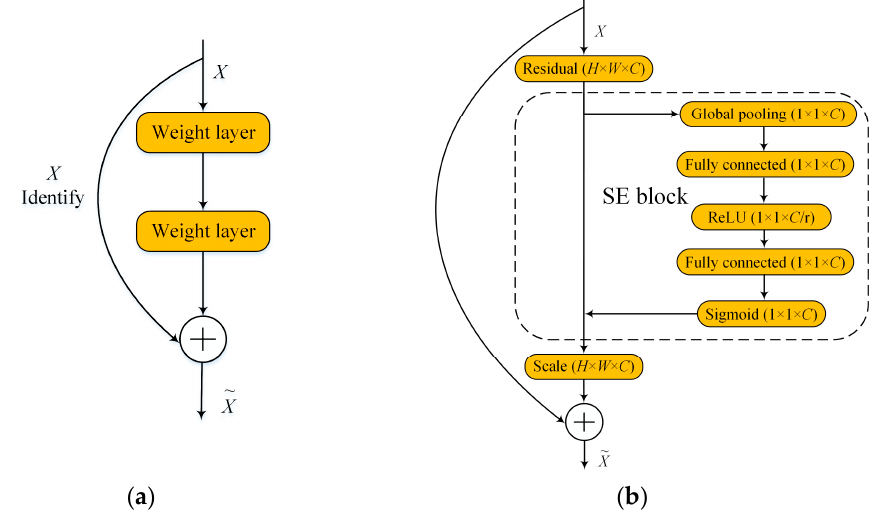
Figure 6. ResNet module and SE-ResNet module: ( a ) ResNet module; ( b ) SE-ResNet module.